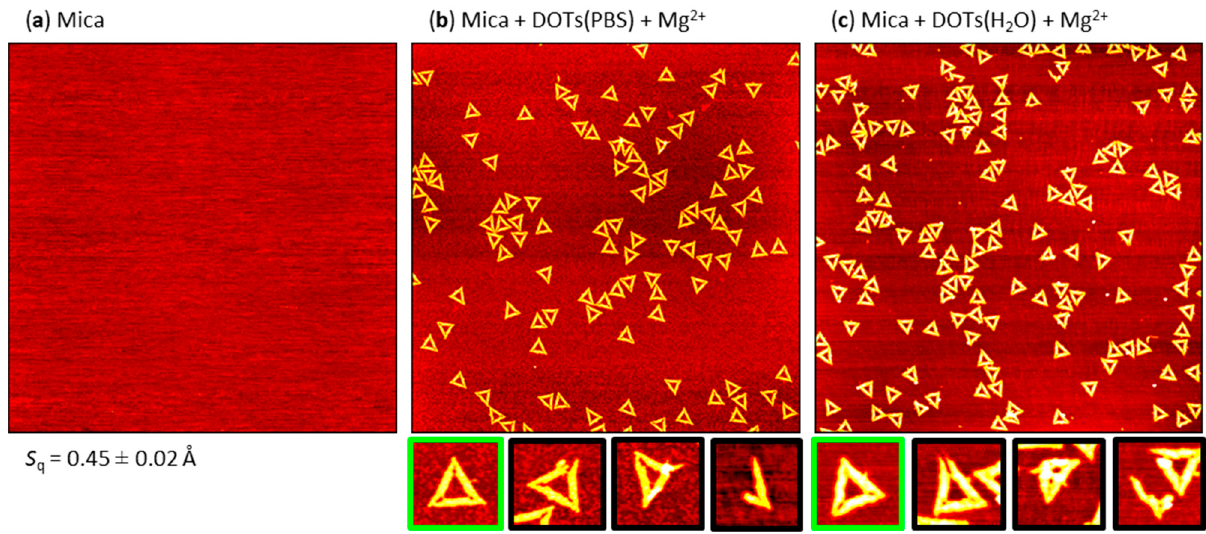
Figure 2. Representative AFM images of ( a ) a freshly cleaved mica surface and DOTs adsorbed from ( b ) PBS and ( c ) H 2 O at the mica surface after addition of 10 mM MgCl 2 (in 1 × TAE). The AFM images have a size of 3 × 3 µm² and a height scale of ( a ) 1.5 and ( b , c ) 2.5 nm, respectively. The RMS roughness S q of the freshly cleaved mica surface (average of three AFM images ± standard deviation) is given below the AFM image in ( a ). Below ( b ) and ( c ), example magnifications of intact (green) and damaged (black) DOTs are shown.